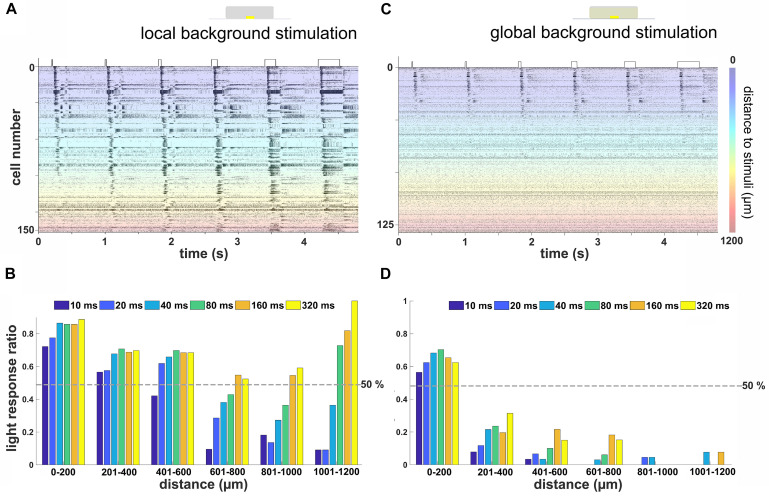
Remote activation in retinal ganglion cells (RGCs) from local light stimulus is background and duration dependent. (A) Raster plot of RGCs from one flat-mounted retina stimulated with local stimuli of durations on a local background. The Y-axis marks the number of cells in one retina, each of them stimulated 12 times. The color codes for the distance of the RGC from the local stimulus. Most of the RGCs located close to the stimulus (blue-green area) were activated by all stimulus durations, while the RGCs located at the far distance (orange-red area) only responded to relatively longer stimuli. (B) Ratio of RGCs with robust light response for different stimulus durations on local background versus distance to stimulus center (n = 385 RGCs from three retinas). (C) Rasterplot of RGCs from the same flat-mounted retina shown in (A) with stimulation on a global background. Most RGCs located close to the light stimulus show light responses, while those located distally were not activated. The scale bar marks the distance of the RGC from the stimulus center. (D) Similar evaluation as in (B) for stimulation on a global background. Few RGCs located further than 200 μm away from the stimulus showed a robust light response (n = 281 RGCs from three retinas).